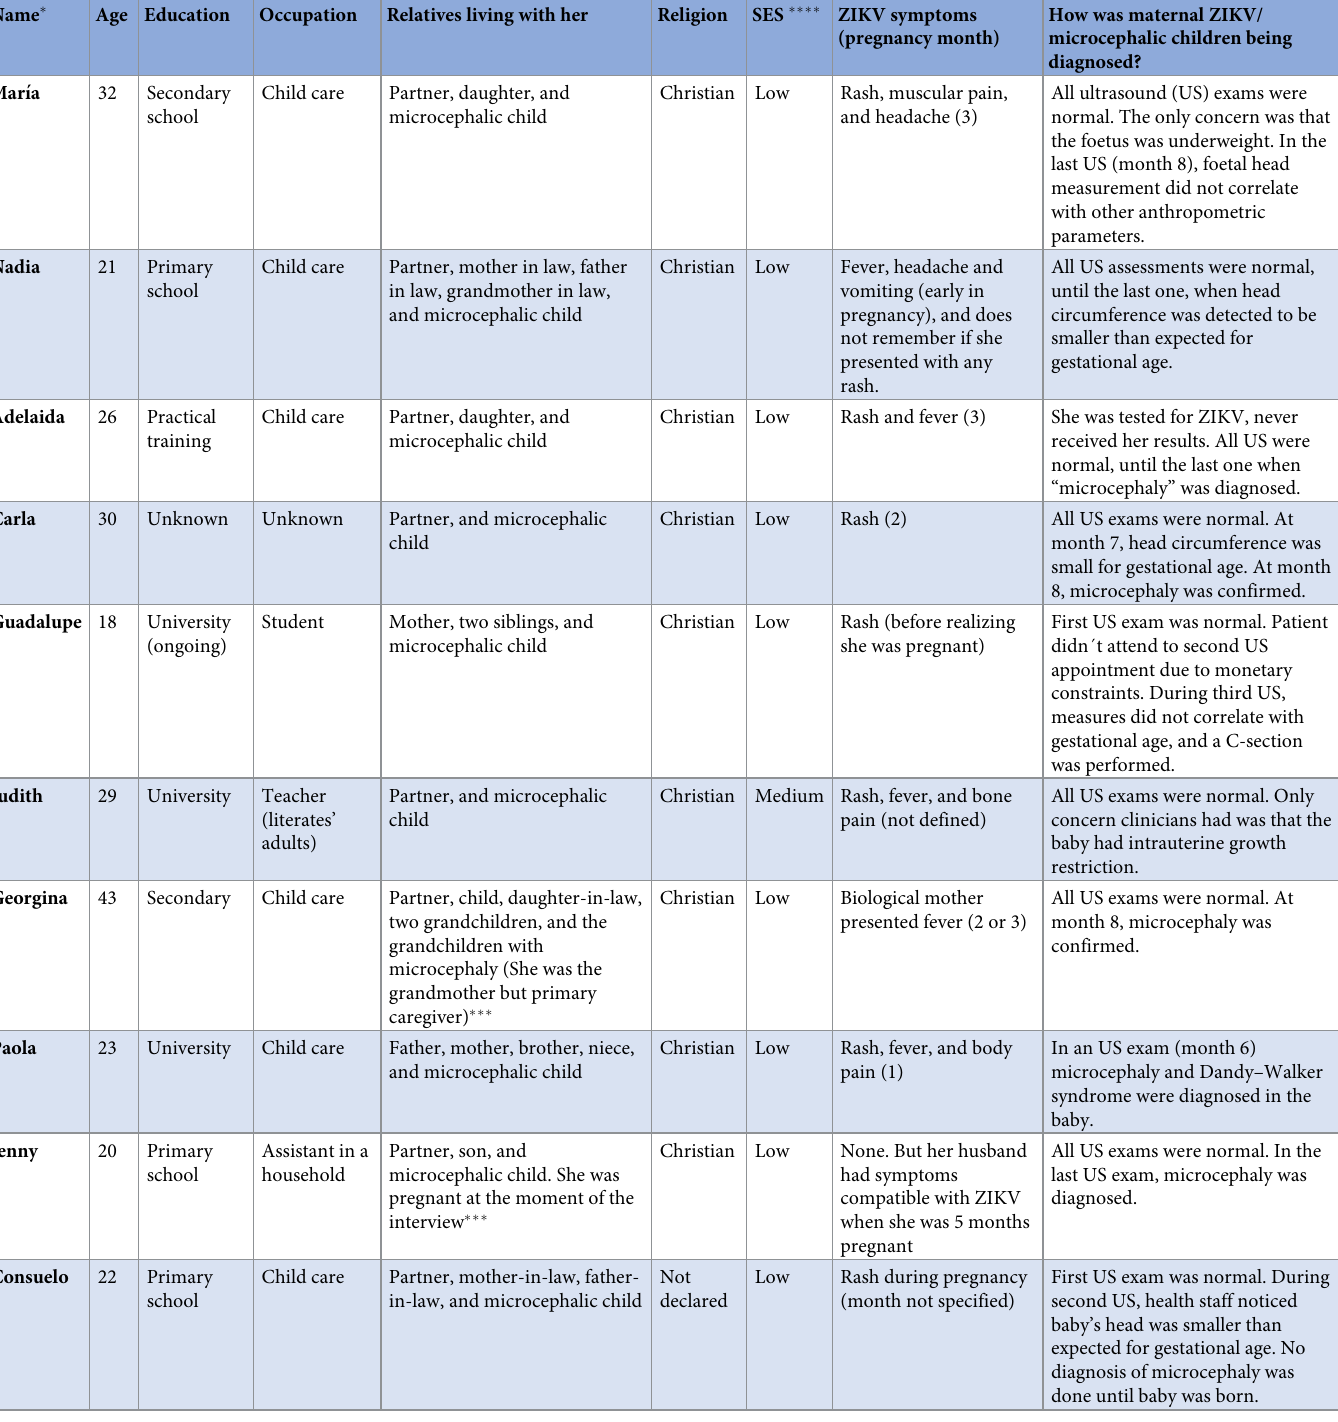
Table 1. Sociodemographic characteristics of women participating in the study, ZIKV-associated symptoms during pregnancy, and description of microcephaly